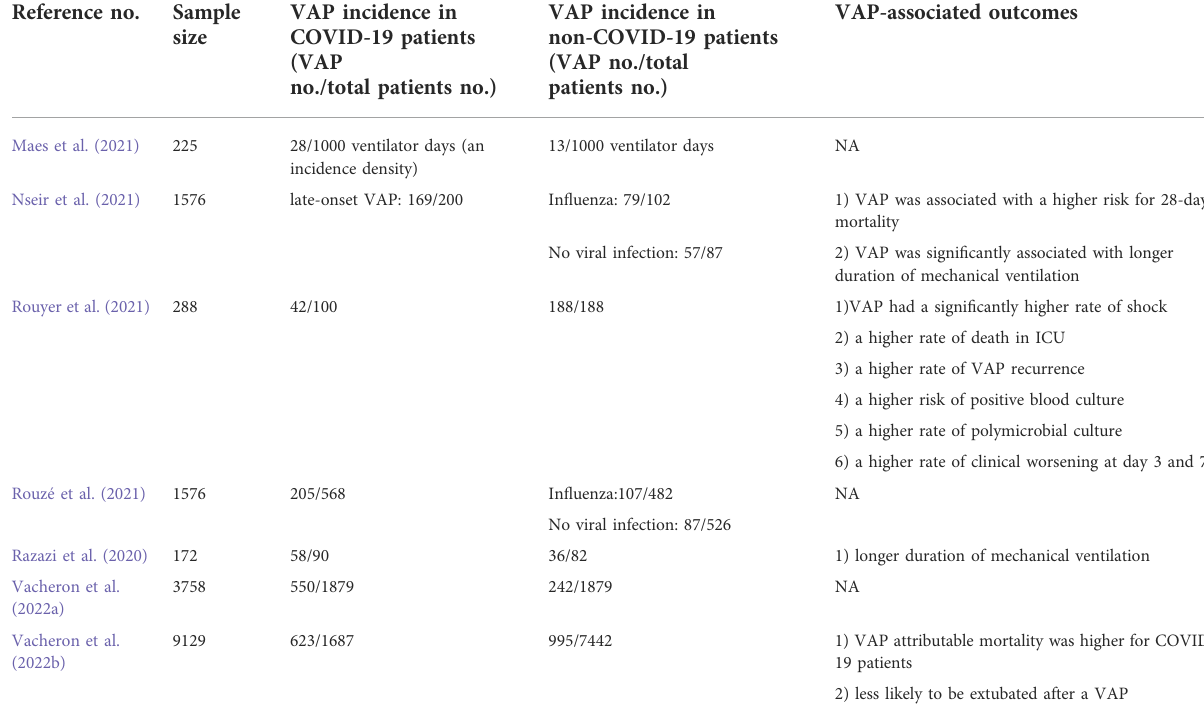
TABLE 1 The characteristics of studies reported ventilator-associated pneumonia in COVID-19. Reference